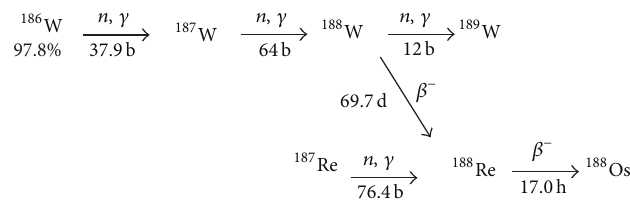
Figure 1: Scheme for reactor production of 188 W.